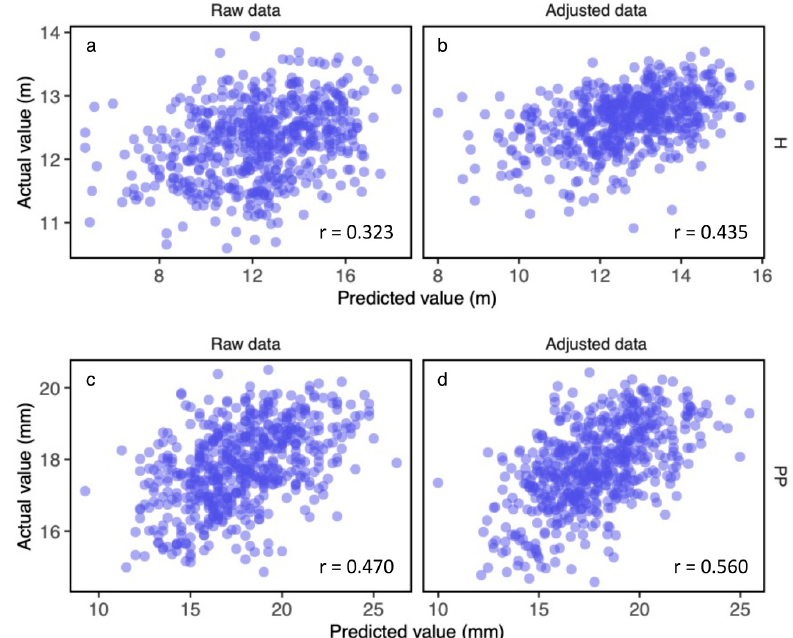
Figure 5. Relationships between actual and predicted trait values for tree height (H) for ( a ) raw data and ( b ) adjusted data, and for pyridine penetration depth (PP) for ( c ) raw data and ( d ) adjusted data. Genomic predictions within the F 1 population are shown. Predicted values were estimated by the genomic prediction model with data from random forest (RF). The relationships with the highest correlation e ffi cient (r) were estimated by a round of 10-fold cross-validation, as shown for each trait without or with